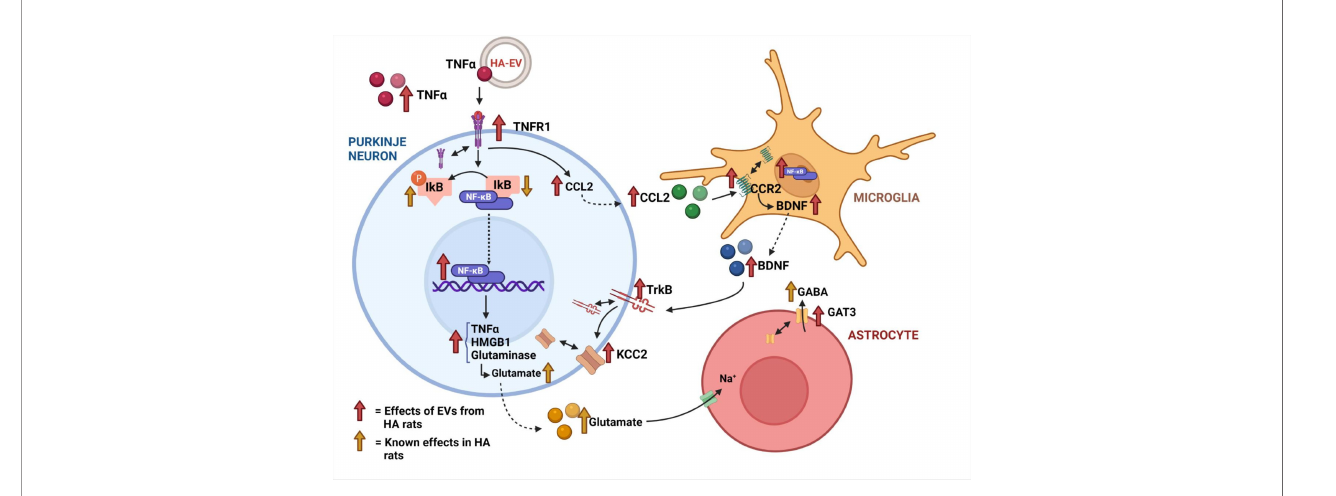
FIGURE 7 | Summary of the ex vivo effects of extracellular vesicles from hyperammonemic rats on cerebellar slices from control